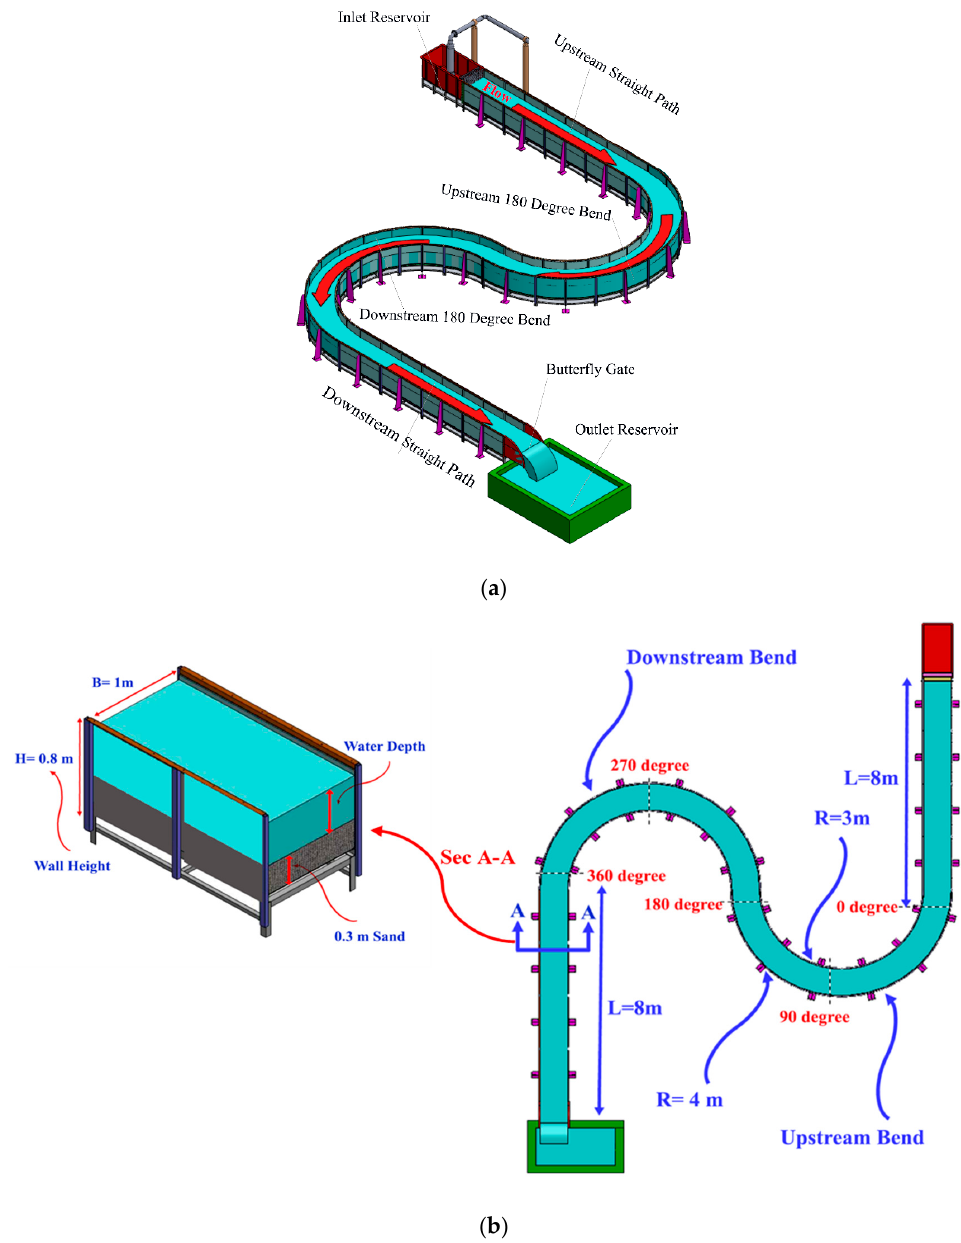
Figure 1. Schematic illustration of ( a ) 3D view and ( b ) plan and cross-sectional views of the meandering channel. As Raudkivi and Ettema [24] recommended, the mean particle diameter (d 50 ) must be larger than 0.07 cm to prevent dunes formation [25]. Hence, the channel bed is covered with a 30-cm-thick layer of silica sand with d 50 = 0.185 cm and a standard deviation of 1.2. Given the criterion suggested by Chiew [26], the tests were considered to run for 4 h. To supply the required water to the channel, side reservoir tanks with a capacity of 30 m 3 have been used. The discharge capacity produced by the pump system was constantly maintained as 70 Lit/s when running the tests. The ultrasonic Aktek (Type: TFM3100-F1)